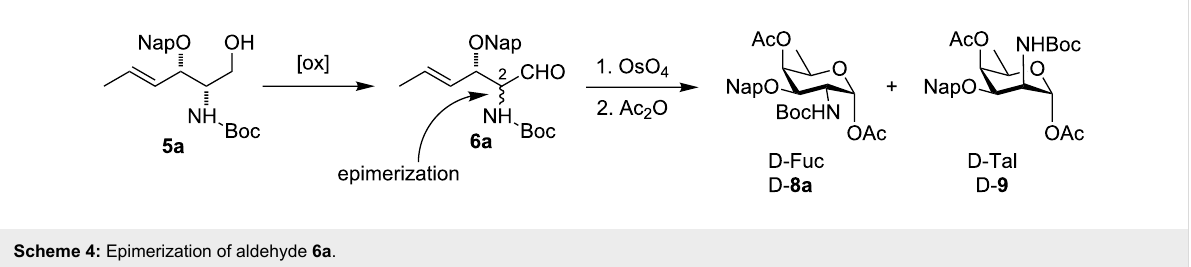
Scheme 4: Epimerization of aldehyde 6a .